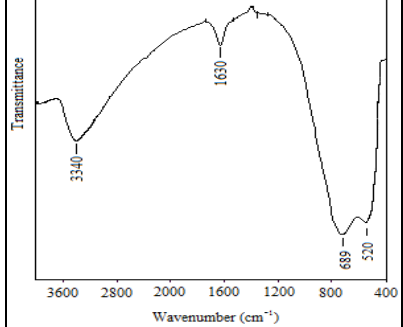
Fig. 3. The FT-IR spectra of the nano TiO